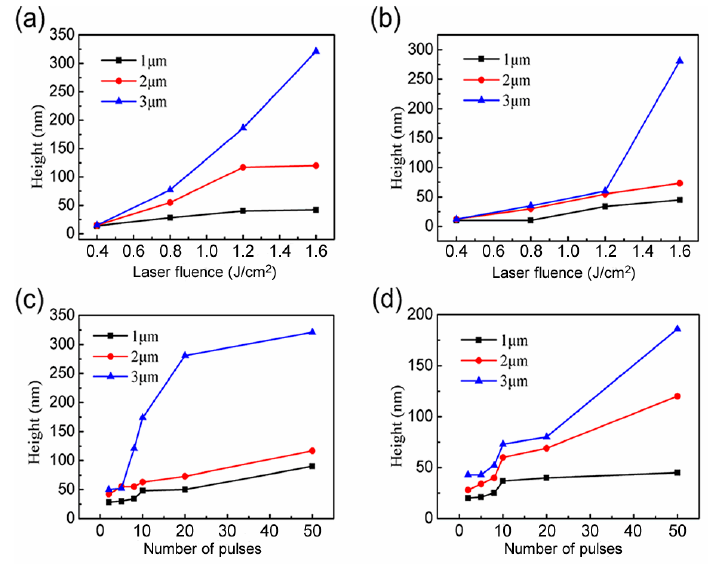
Figure 3. Curves of height variation of different periodic structures. Height varies with the laser power at the exposure time of ( a ) 5 s; ( b ) 2 s; and with the exposure time at a laser power of ( c ) 0.8 W; ( d ) 0.6 W.